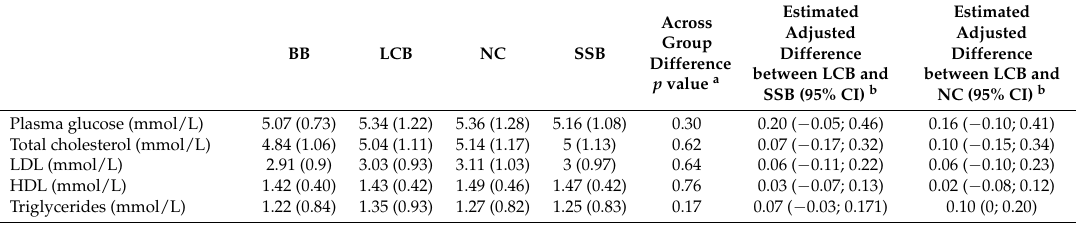
Table 4. Plasma glucose and lipid profile according to type of beverage